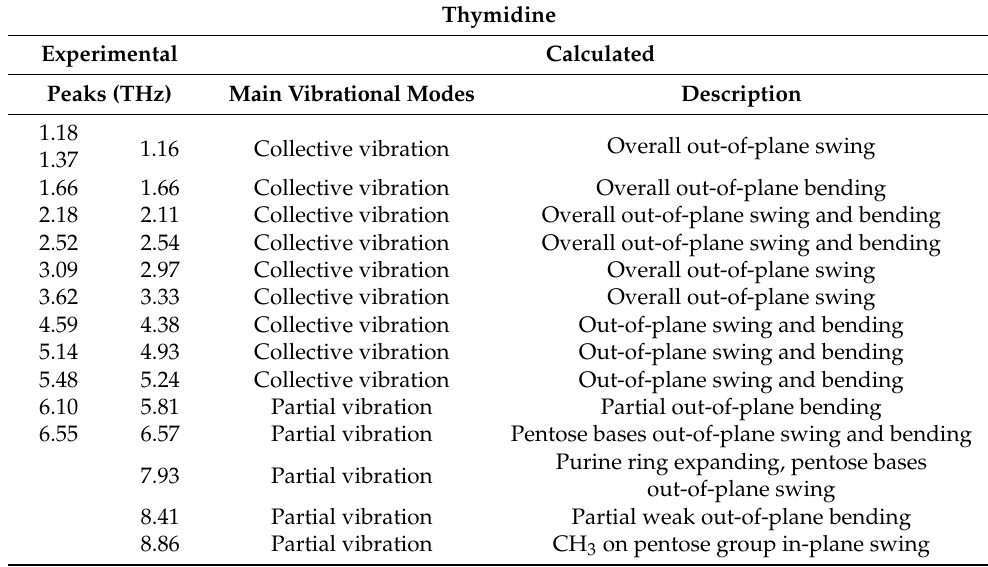
Figure 3. ( a ) The single-cell structure of thymidine with hydrogen bonds and Van der Waals forces, ( b ) comparison of experimental and calculation (crystal) spectra of thymidine based on PBC-GEBF method by using Gaussian09 software. Table 1. Experimental and calculated THz vibrational frequencies and corresponding vibrational modes for